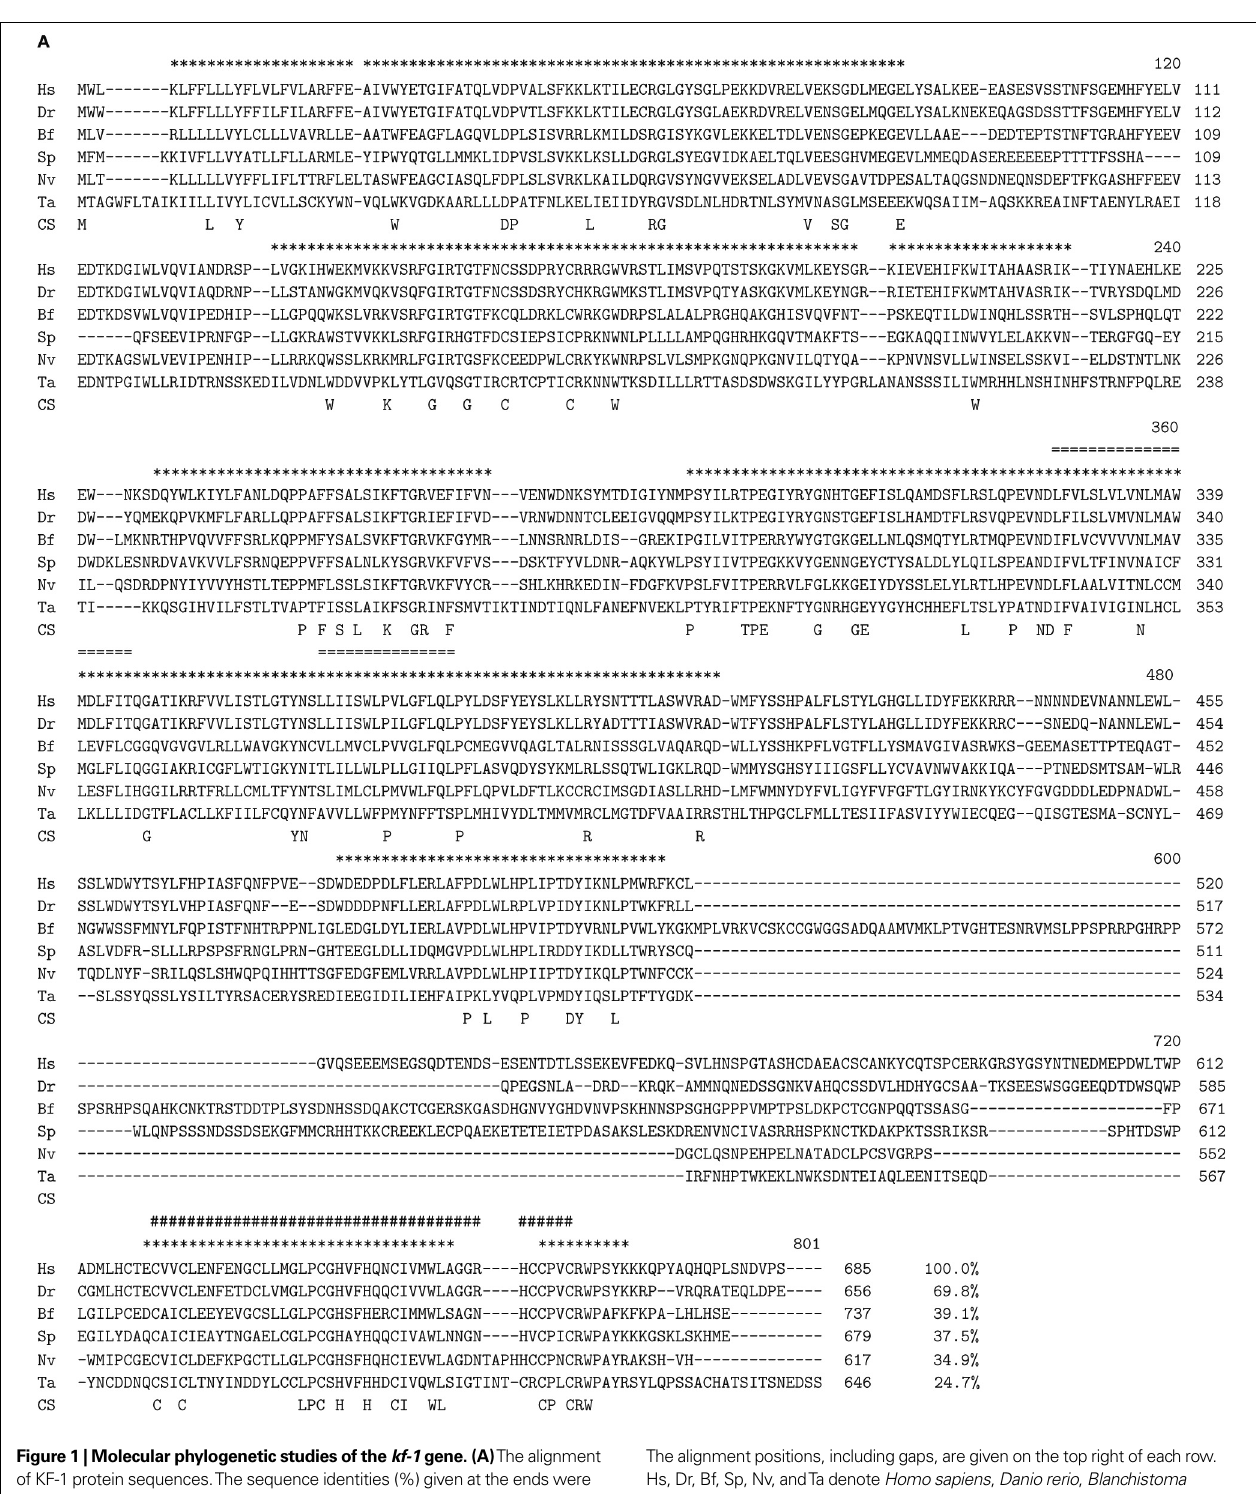
Figure 1 | Molecular phylogenetic studies of the kf-1 gene. (A) The alignment of KF-1 protein sequences. The sequence identities (%) given at the ends were obtained against human sequences minus the regions after the RING-H2 fi nger motif, namely after amino acid position 621 in human KF-1. Asterisks show the alignment sites used for inferring the molecular phylogenetic tree in (B) . The two transmembrane regions of human KF-1 are indicated by ‘=’ and the RING-H2 fi nger motif for zinc-binding is indicated by ‘#’. The number given at the right side indicates the amino acid position of the C-terminal amino acid in each line.